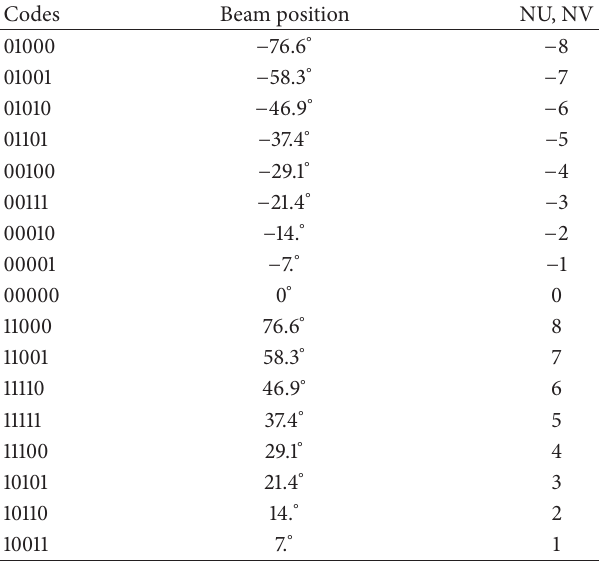
Table 1: Beamformer codes and beam angles from the